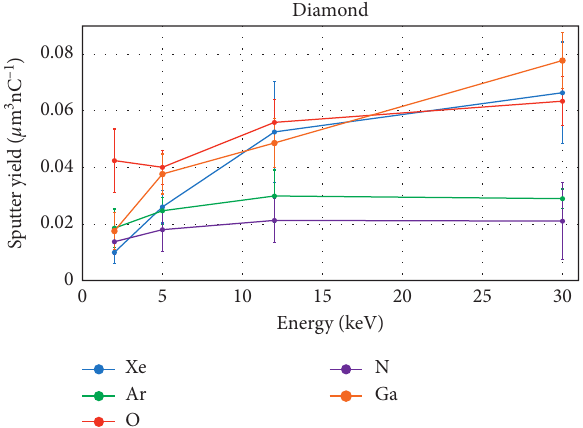
Figure 11: Sputter yield of diamond milled with different ion species at varying energies.